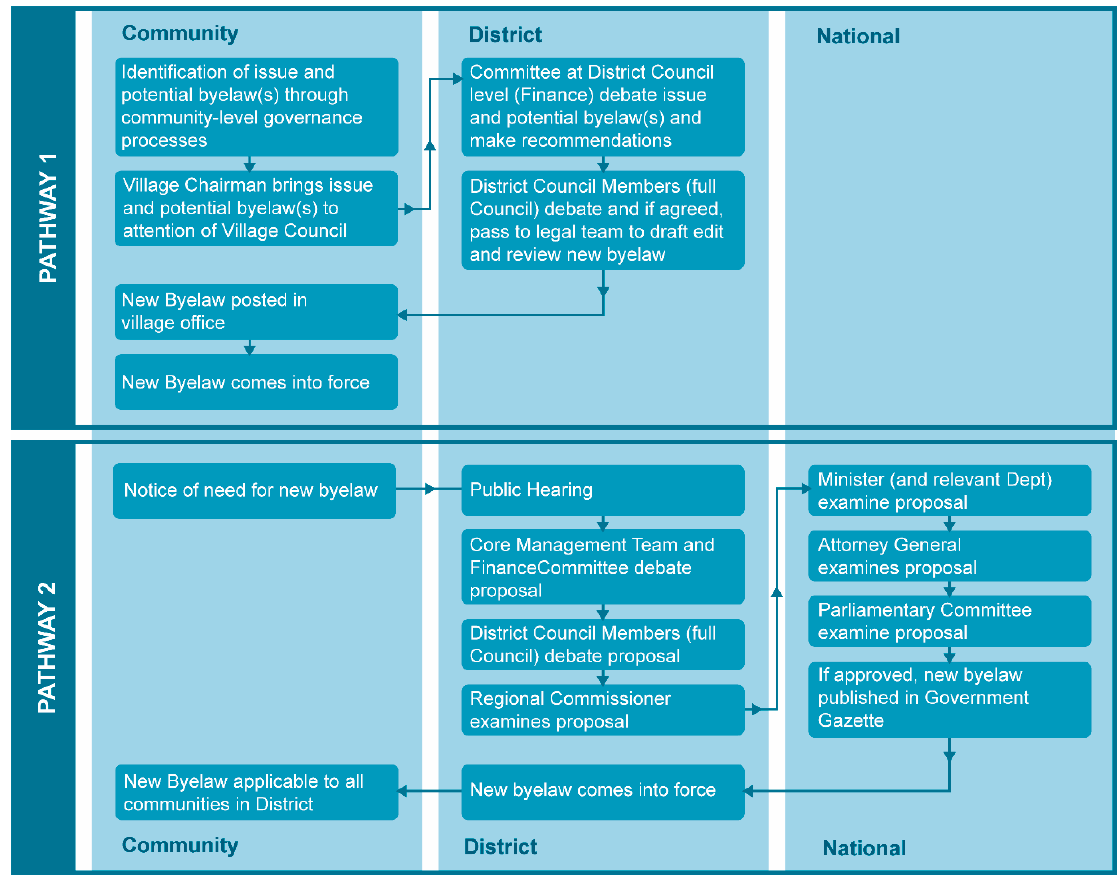
Figure 2. Two pathways for community-level policy instruments (byelaws) in Tanzania .